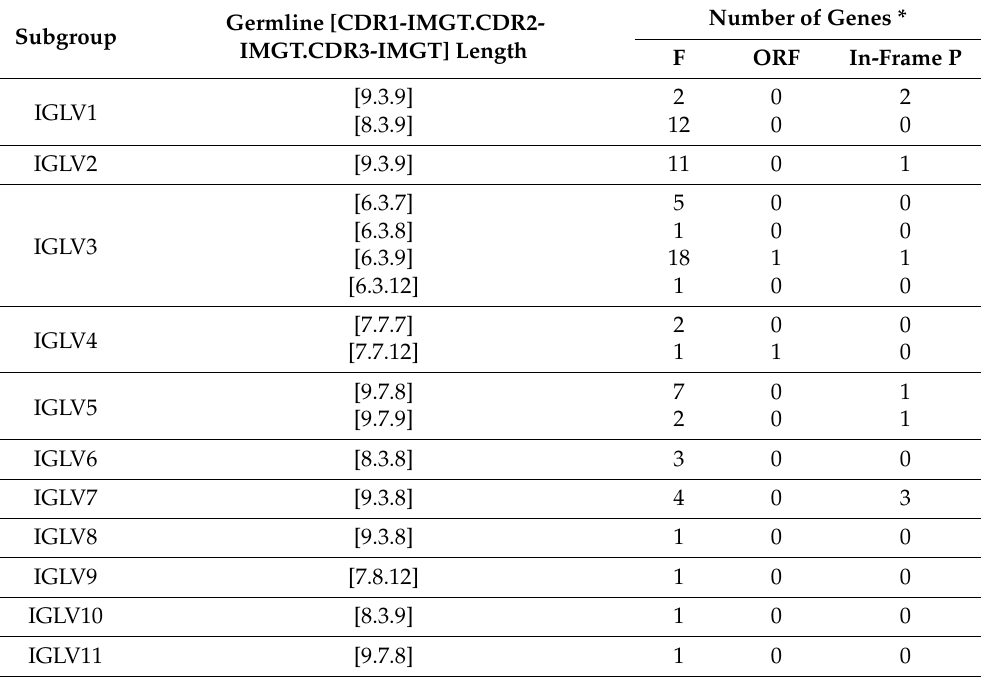
Table 11. CDR-IMGT lengths distribution in each IGLV